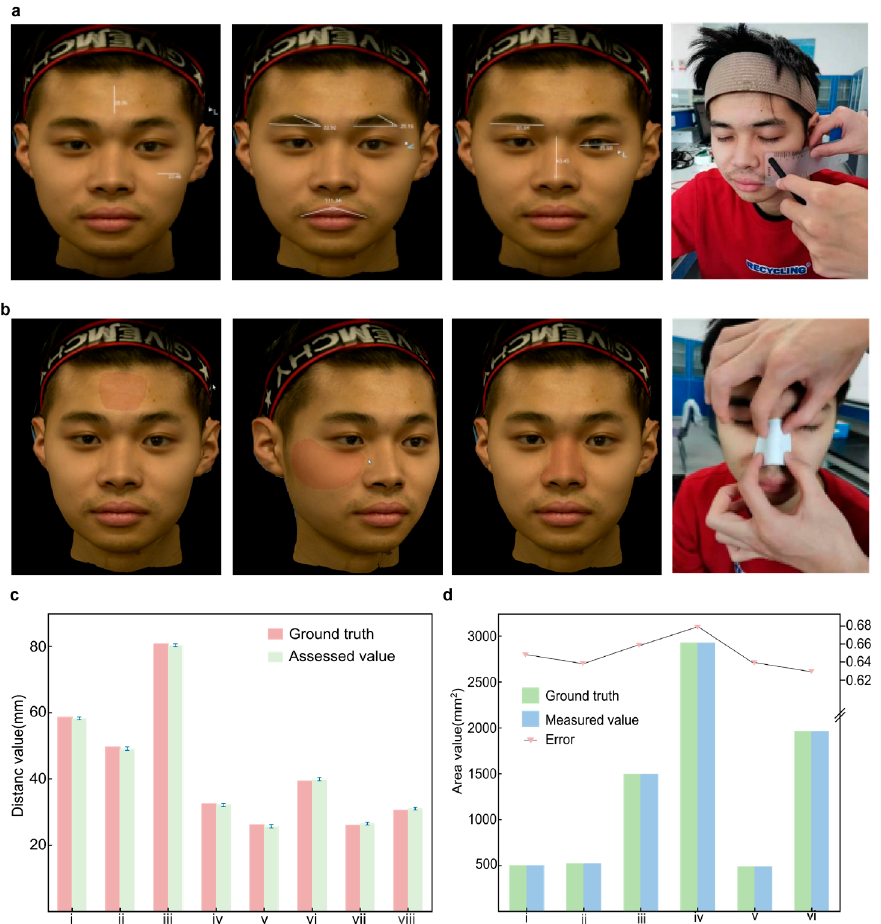
Figure 2. The measurement of the human face using the system. ( a ) geometric feature measurement. ( b ) 3D area measurement. ( c ) average error of geometric measurement. ( d ) average error of area measurement.